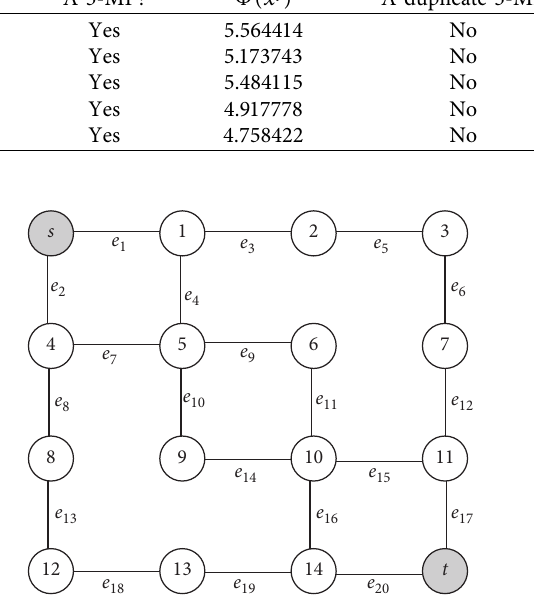
Figure 4: A test network for example